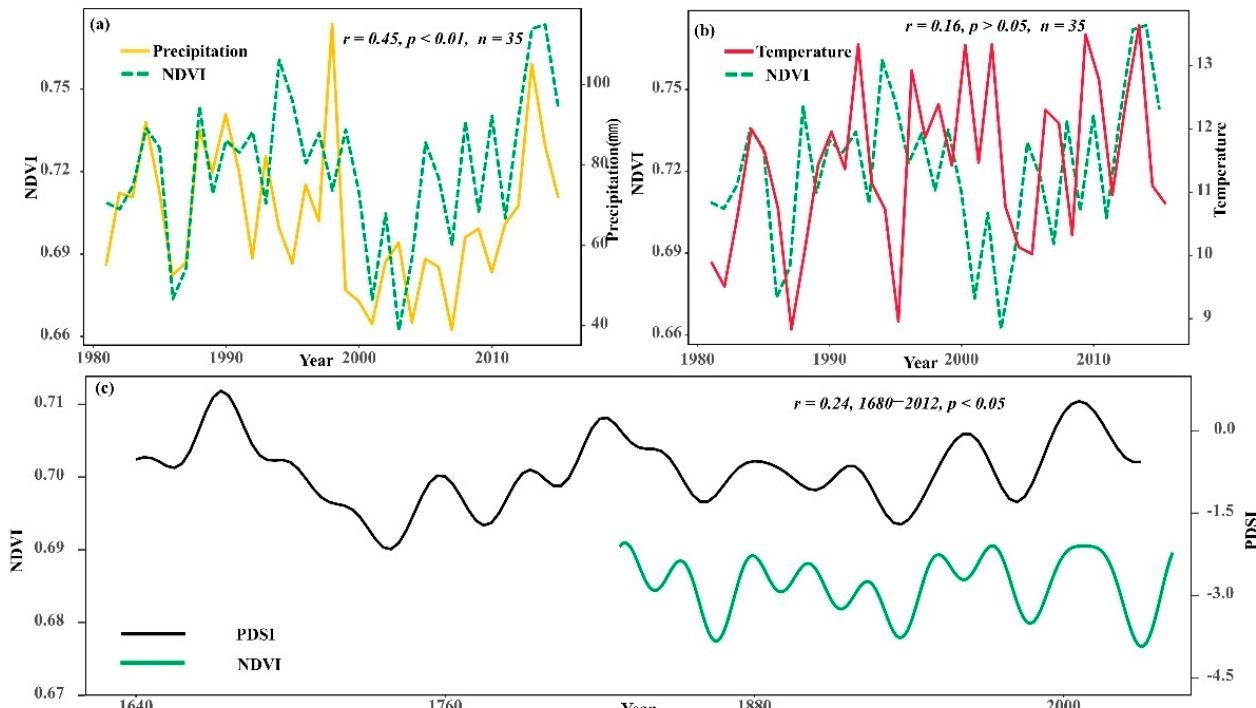
Figure 8. Relationship between the summer NDVI and precipitation, temperature, and the Palmer Drought Severity Index (PDSI). The NDVI and observed precipitation ( a ) and temperature ( b ) in the growing season; the NDVI and PDSI in Hulunbuir ( c ). ( c ) shows the correlation analysis for the common time period only, due to the different time lengths: 1826–2012.